Question: What visual encoding does this figure use to show its data?
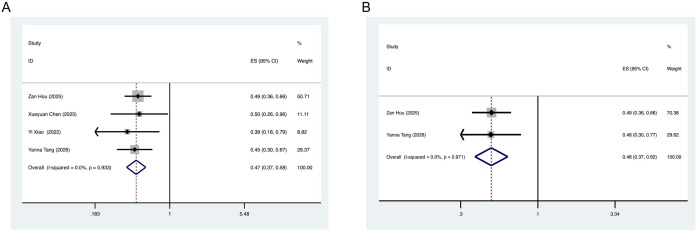
Answer: forest